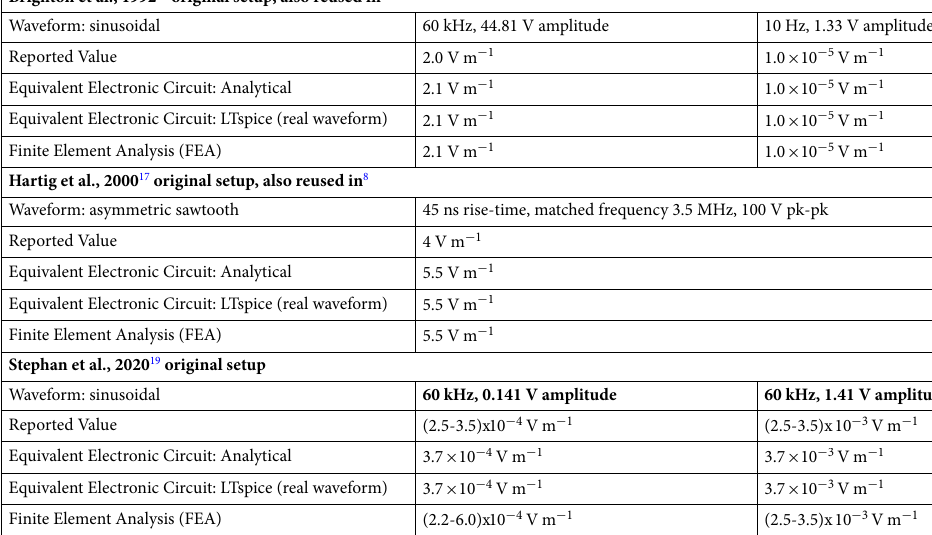
Table 3. List of studies where an agreement was observed between the reported and predicted magnitude of the E-Field in the culture